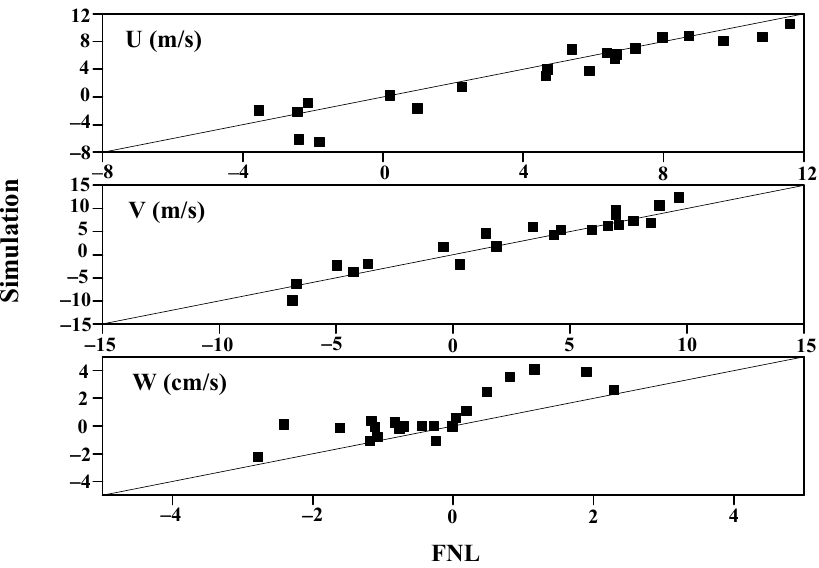
Figure 18. Velocity scatter plot of the simulation versus the FNL (The line y = x is also plotted).